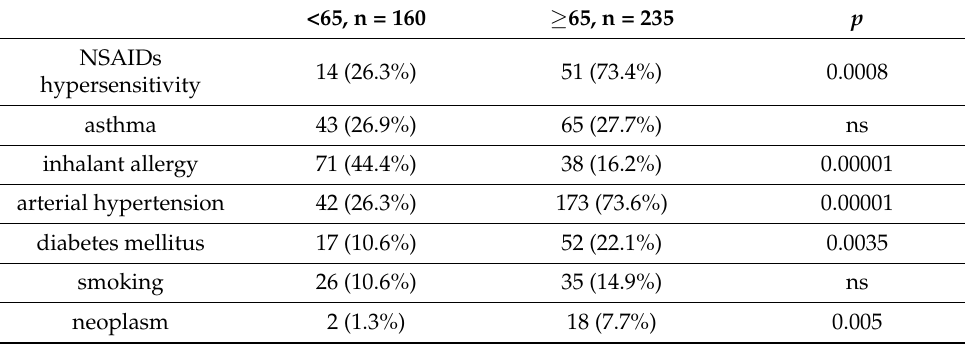
Table 2. Frequencies of comorbidities in both groups of